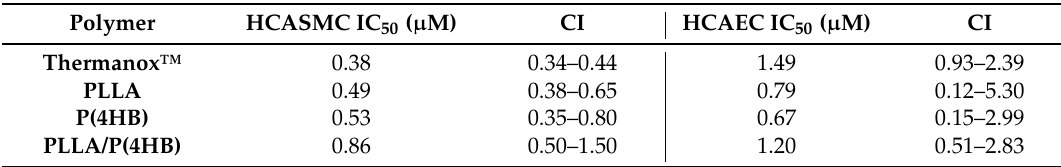
Table 1. IC 50 of ATOR on HCASMC and HCAEC grown on different polymer surfaces. IC 50 values were calculated from sigmoidal dose-response curves as the concentration of ATOR causing 50% reduction in cell growth. The 95% confidence intervals (CI) are indicated.